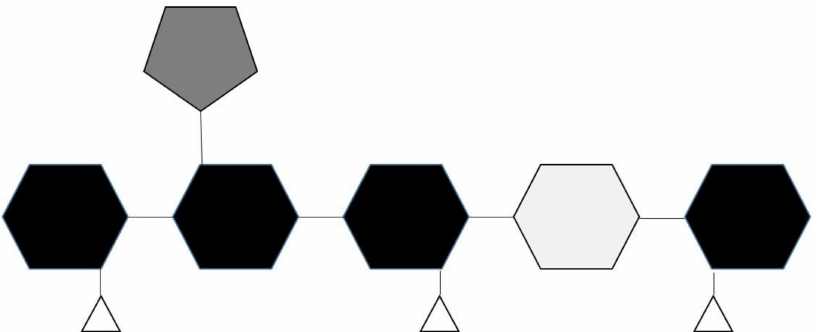
Figure 1. The basic structural components found in mannans. Their backbone is made of β -1,4-linked mannose residues “black hexagon” which may be randomly interspersed with glucose residues “light grey hexagon”, the mannose residues may also contain α -1,6-linked galactose sidechains “dark grey pentagon”, and acetyl group substitutions at the O-2 and O-3 positions “white